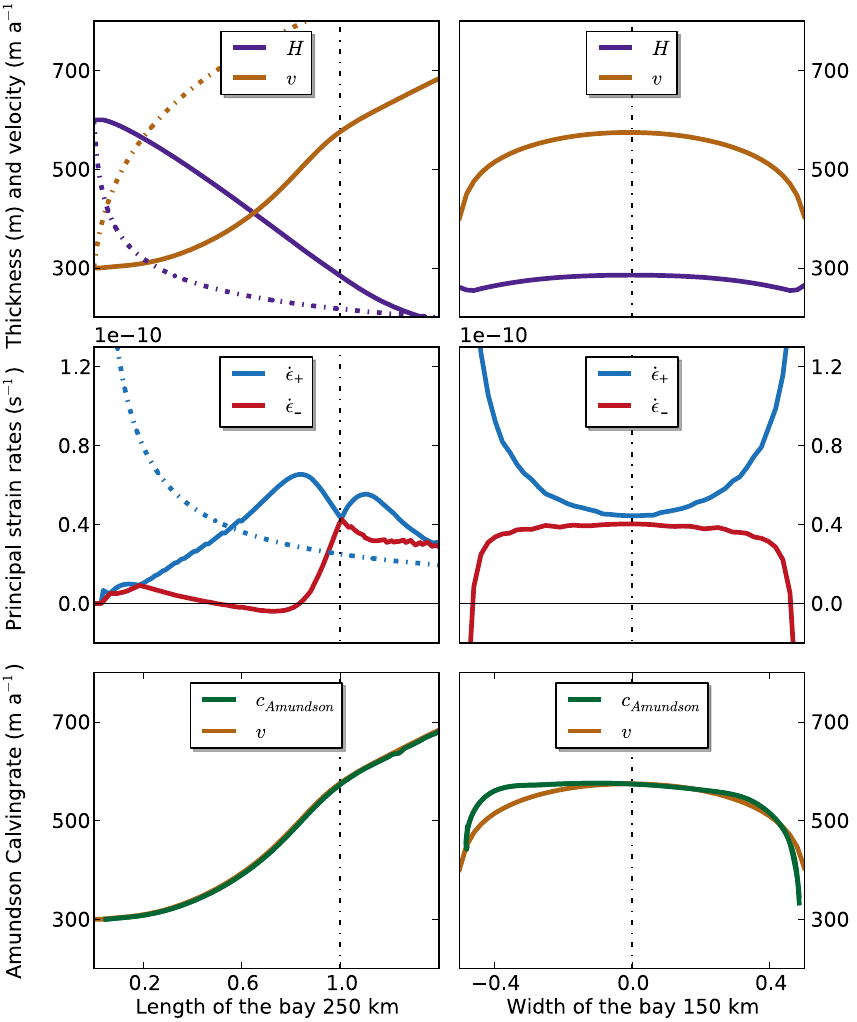
Fig. 8. Comparison with relation derived for steady-state calving rate from the SSA-equation (Amundson and Truffer, 2010). Properties for an ice shelf confined in a rectangular narrow basin of 150 × 10 3 m width and 250 × 10 3 m length with time-dependent calving according to Eq. (1). Left column: properties for the center-line along the main flow direction. Right column: properties for a cross-section at the mouth of the embayment. Shown are ice thickness and speed ( H and v , top) along with the spreading rate components (middle). Analytic solutions for an unconfined ice shelf are provided as dashed curves. The lower panels compare the steady-state estimate of the calving rate as computed from Amundson and Truffer (2010) with the ice speed. While the two compare very well along the center-line, the estimate deviates slightly near the margin where buttressing becomes important and the assumption that the ice velocity has the same direction as the gradient of H becomes slightly less accurate. The good agreement shows that at the calving front at which the Amundson and Truffer (2010)-assumptions hold, the calving rate has to be proportional to the trace as well as to the determinant of the spreading rate tensor.